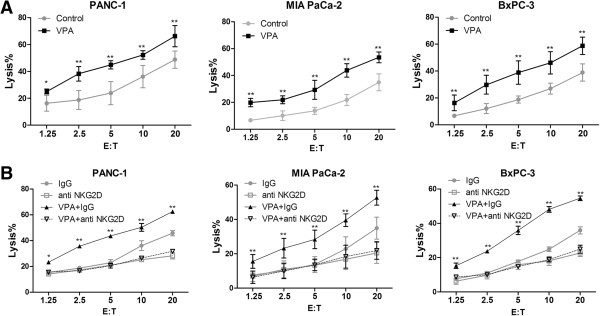
VPA enhances the sensitivity of pancreatic cancer cells to NK cell-mediated lysis via a NKG2D-dependent mechanism. (A) VPA sensitized pancreatic cancer cells to NK cell-mediated lysis; * P < 0.05; ** P < 0.01. (B) Blockade of NKG2D attenuated the ability of VPA to sensitize pancreatic cancer cells to NK cell-mediated lysis; * P < 0.05 for VPA + IgG vs. VPA + NKG2D; ** P < 0.01 for VPA + IgG vs. VPA + NKG2D. Data are mean ± SD of a single experiment performed in triplicate, all results were reproducible in three independent experiments. E:T, effector/ target ratio.